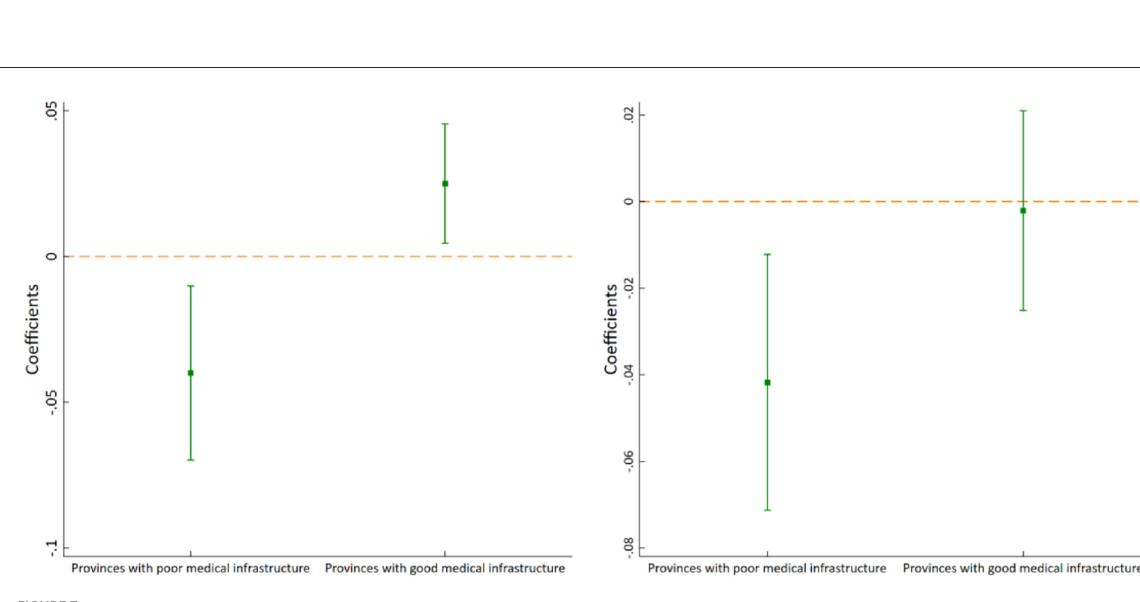
FIGURE7 Medical infrastructure heterogeneity of ln ME_outpatient (left) and ln ME_inpatient (right)